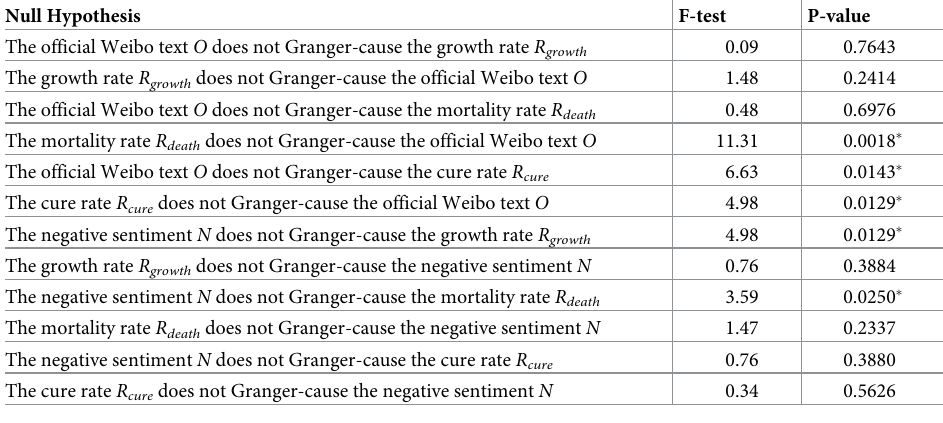
Table 1. Granger test result of different Weibo indicators and COVID-19 epidemic